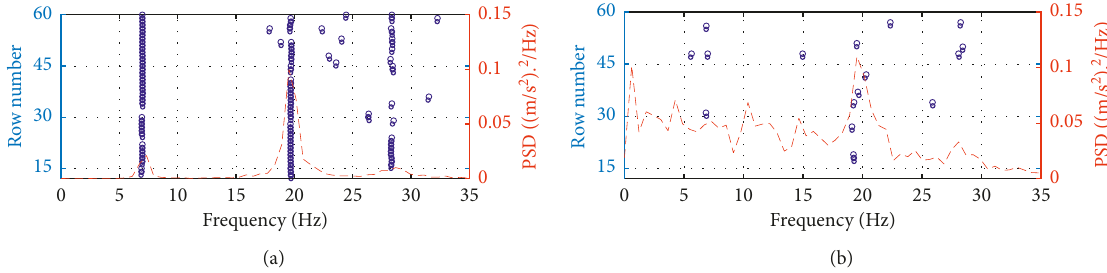
Figure 4: Stabilization diagram of Cov-SSI. (a) SD of Cov-SSI (SNR